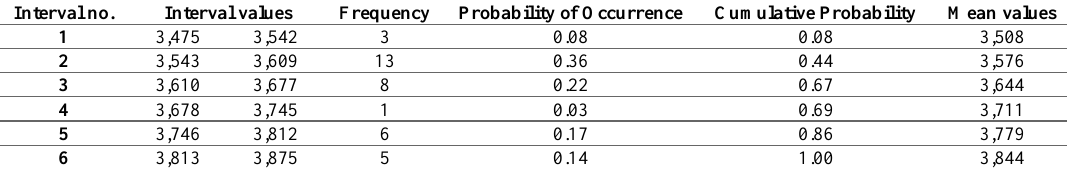
Table 6. Distribution of probability